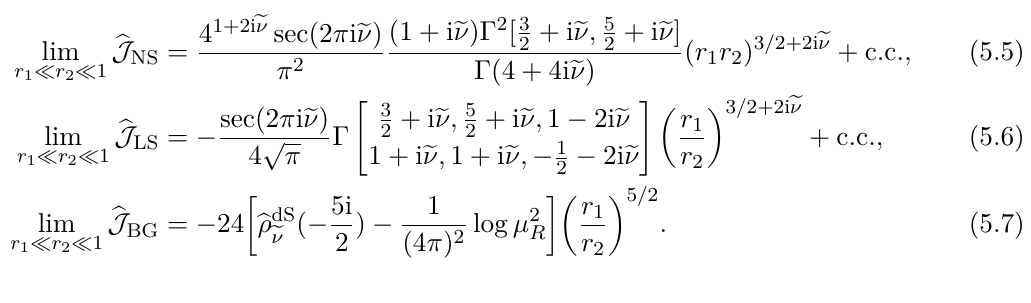
and r , and also in r 1 2